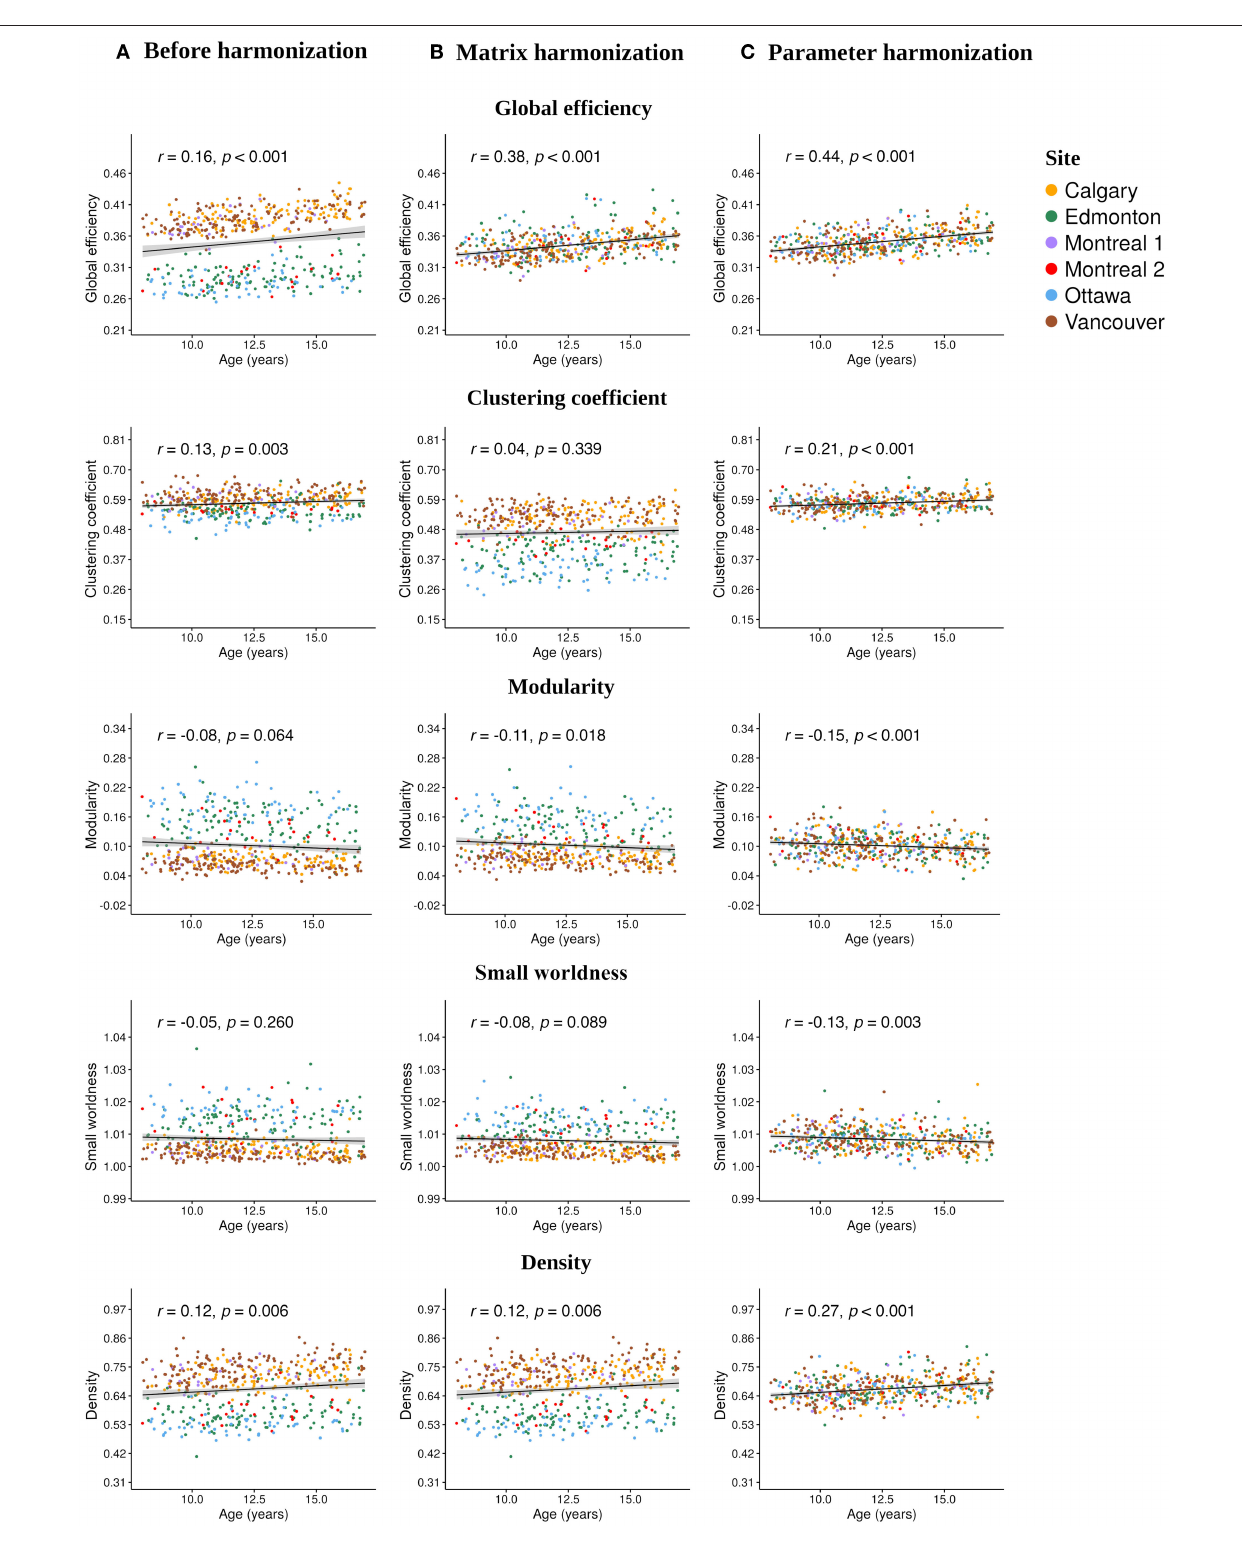
Frontiers in Neurology |